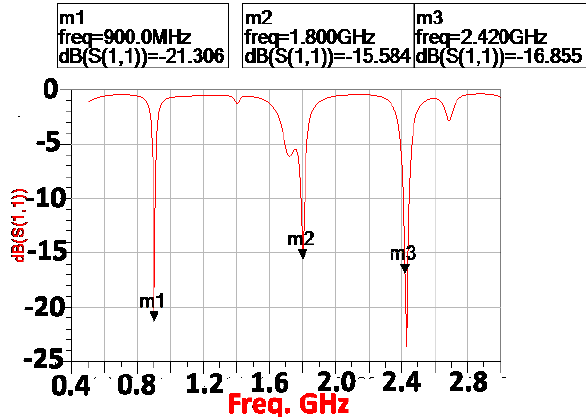
Figure 8: S variation of rectifier 11